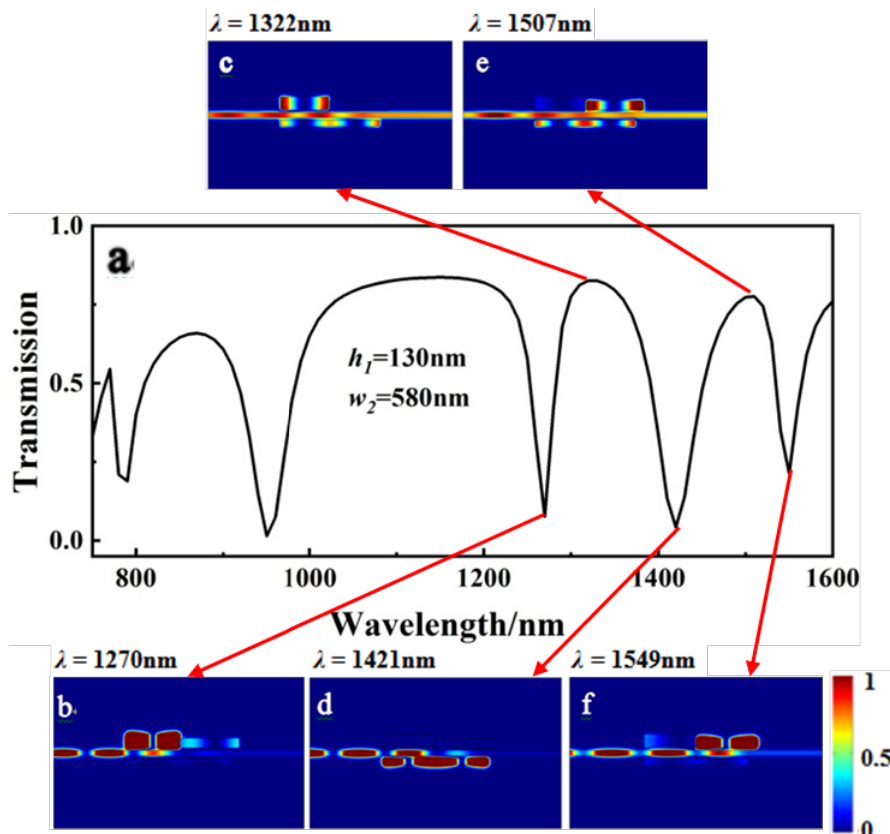
Figure 7. ( a ) Transmission spectrum of the MIM waveguide with the three-rectangle resonators shown in Figure 1 when h 1 and w 2 were synchronously changed. The field distribution |Hz| 2 of the structure at incident wavelengths of ( b ) 1270 nm, ( c ) 1322 nm, ( d ) 1421 nm, ( e ) 1507 nm, and ( f ) 1549 nm.